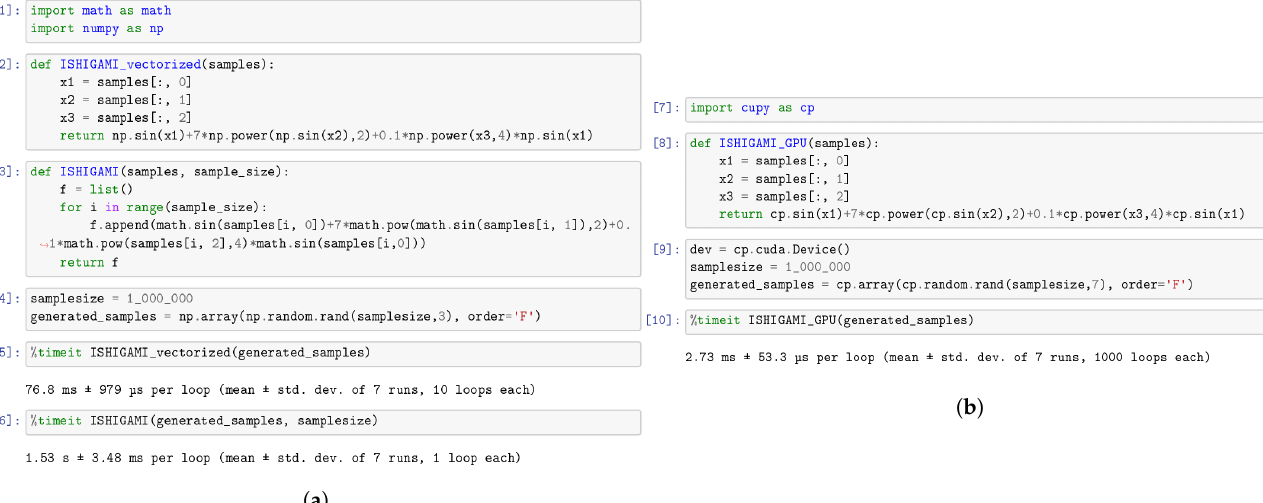
Figure 1. ( a ) Vectorization with NumPy Arrays. ( b ) Use of the GPU architecture with CuPy.